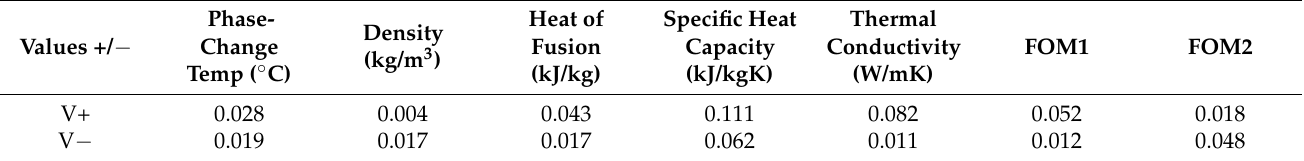
Table 14. Max and min TOPSIS criteria value.